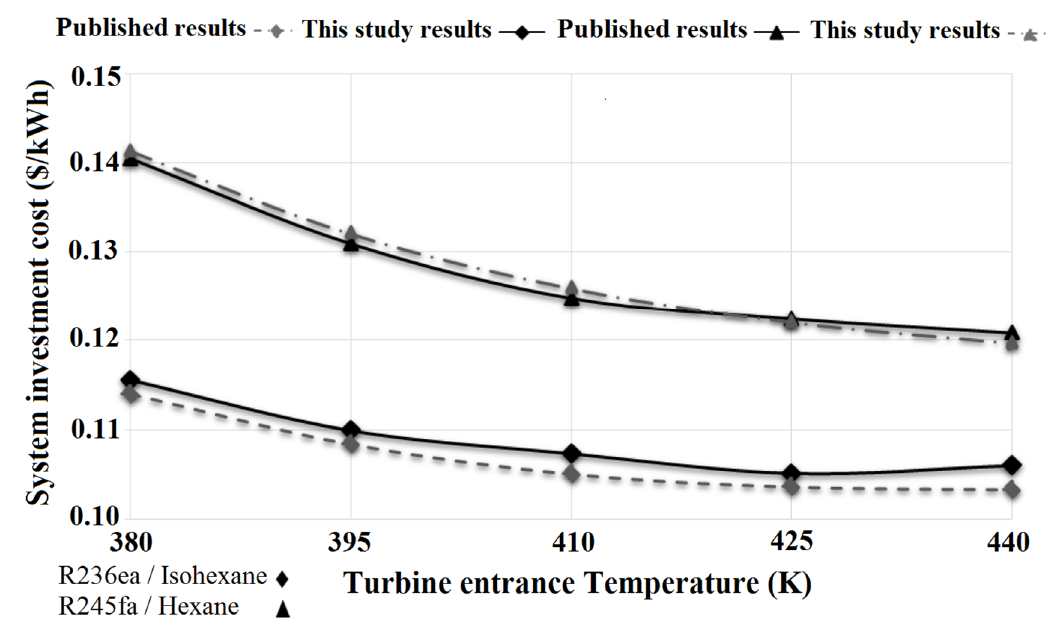
Figure 5. Comparison of the simulated System Investment Cost (SIC) to the similar previously published data [29] for both R236ea/Isohexane and R245fa/Hexane working fluids.